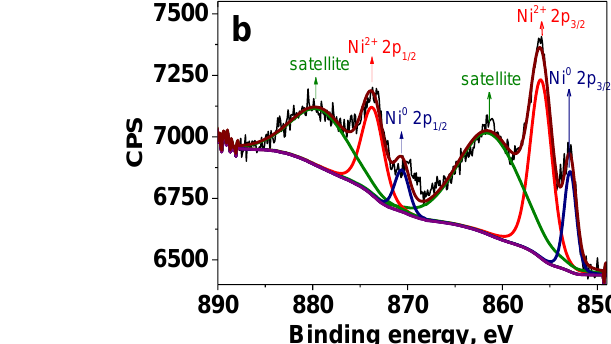
Figure 6. HR XPS of the Ni 2p region of Ni NPs@PPP prepared at 240 °C ( a ) and 280 °C ( b ) by the “injection” method. Deep blue is for Ni 0 , red is for Ni 2+ , green line represents Ni 2+ satellites, brown is for generated fit, purple is for background, and black is for raw data. See Table S2 and Figure S4 for the deconvolution parameters, and survey spectrum, respectively.